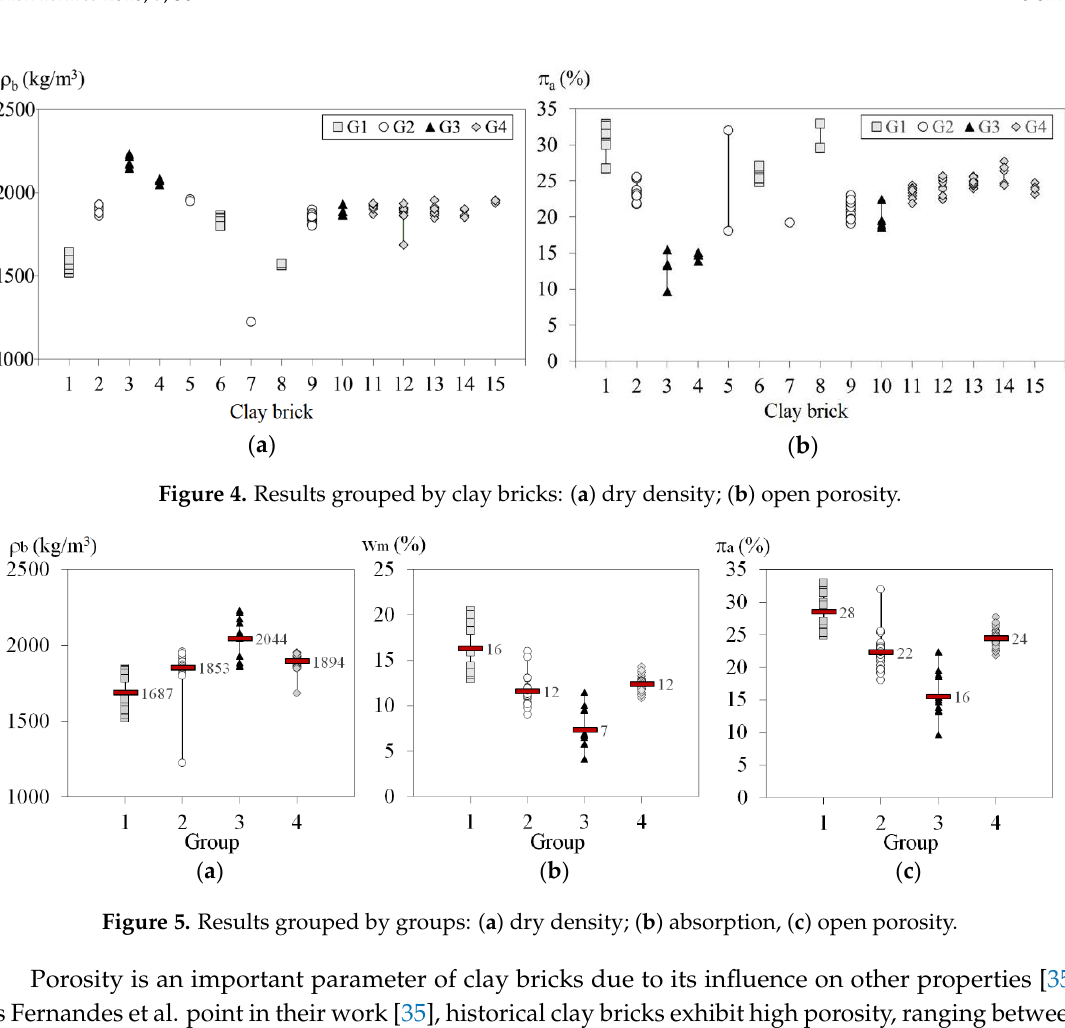
Figure 4. Results grouped by clay bricks: ( a ) dry density; ( b ) open porosity.